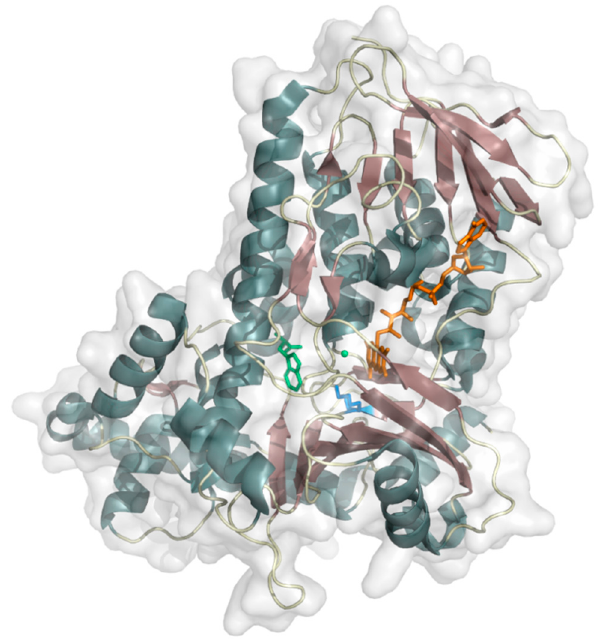
Figure 9. Structure of tryptophan 7-halogenase monomer (PDB ID: 2AQJ). Coloring is according to secondary structure: helices (deep teal), sheets (brown), and loops (pale yellow). The surface is indicated transparently. The FAD cofactor is in orange and L-tryptophan and chloride are in green. Lys79 is indicated in blue [197].